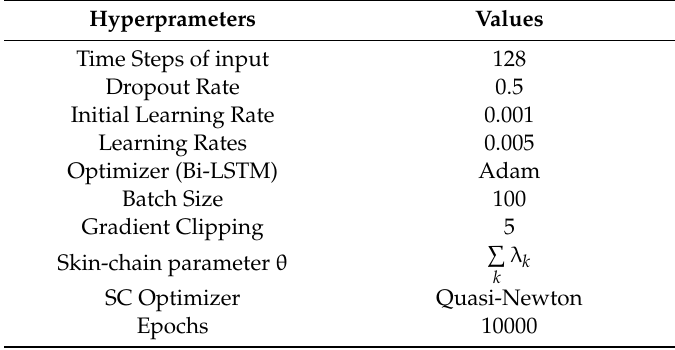
Table 2. Hyperparameter